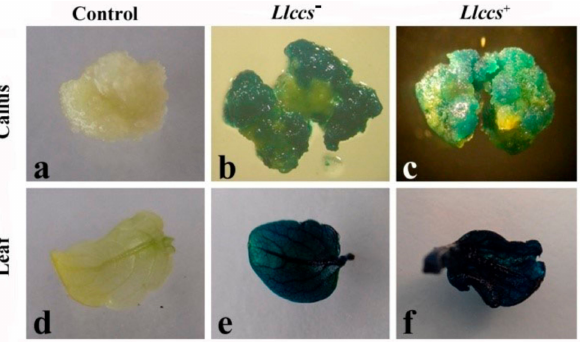
Figure 4. Histochemical GUS assay of control and transgenic Llccs − and Llccs + calli ( a – c ) and leaves ( d – f ).